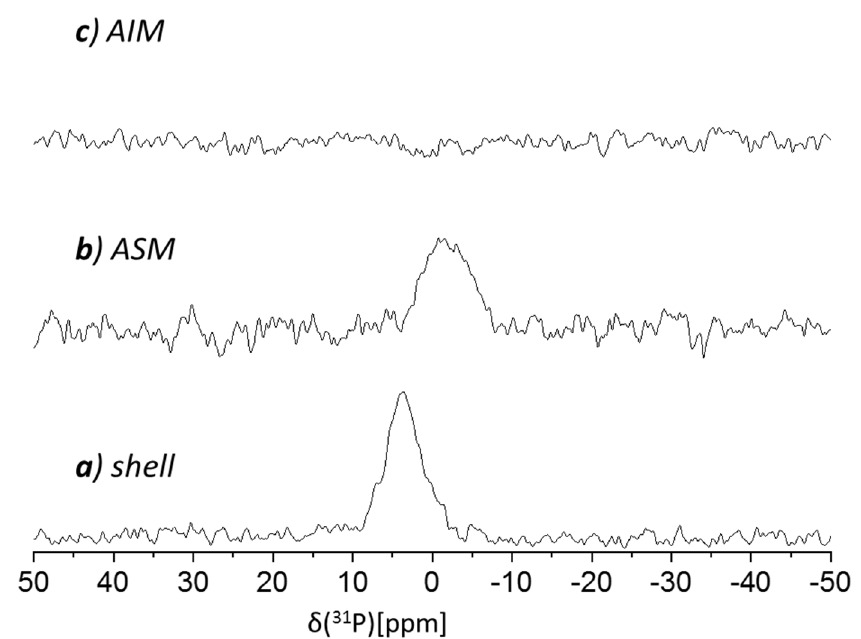
Figure 6. 121.85 MHz 31 P CP MAS NMR spectra of the Argonauta hians shell extracts: ( a ) cleaned shell, ( b ) acid soluble matrix (ASM) and ( c ) acid insoluble matrix (AIM).